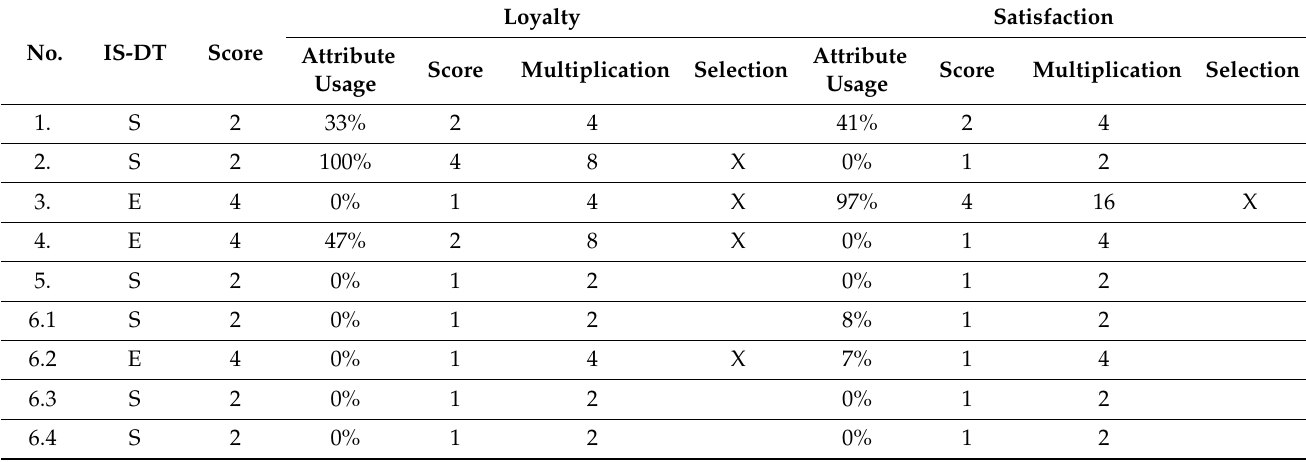
Table 8. Results of the IS-DT feature selection